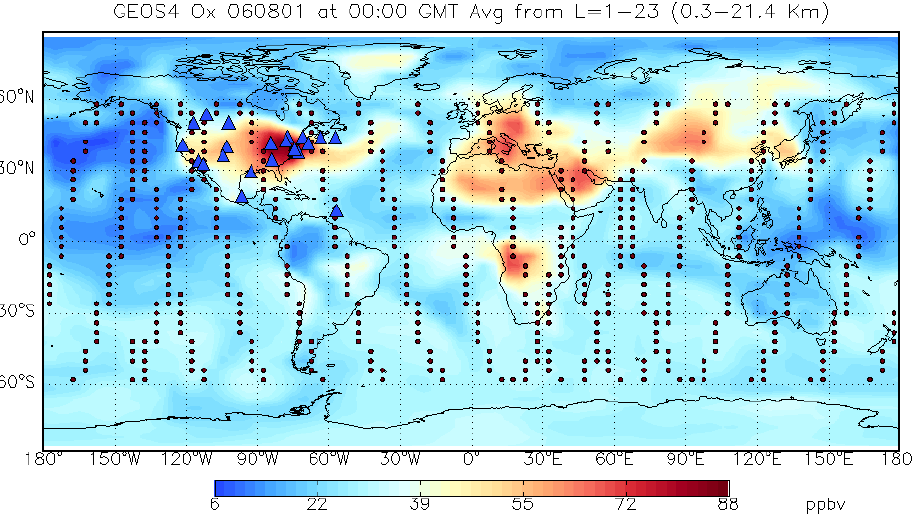
Fig. 3. Ozonesonde sounding stations (triangles) used during IONS06 campaign and AURA/TES satellite trajectory snapshots (dots) plotted over the global ozone distribution on 1 August